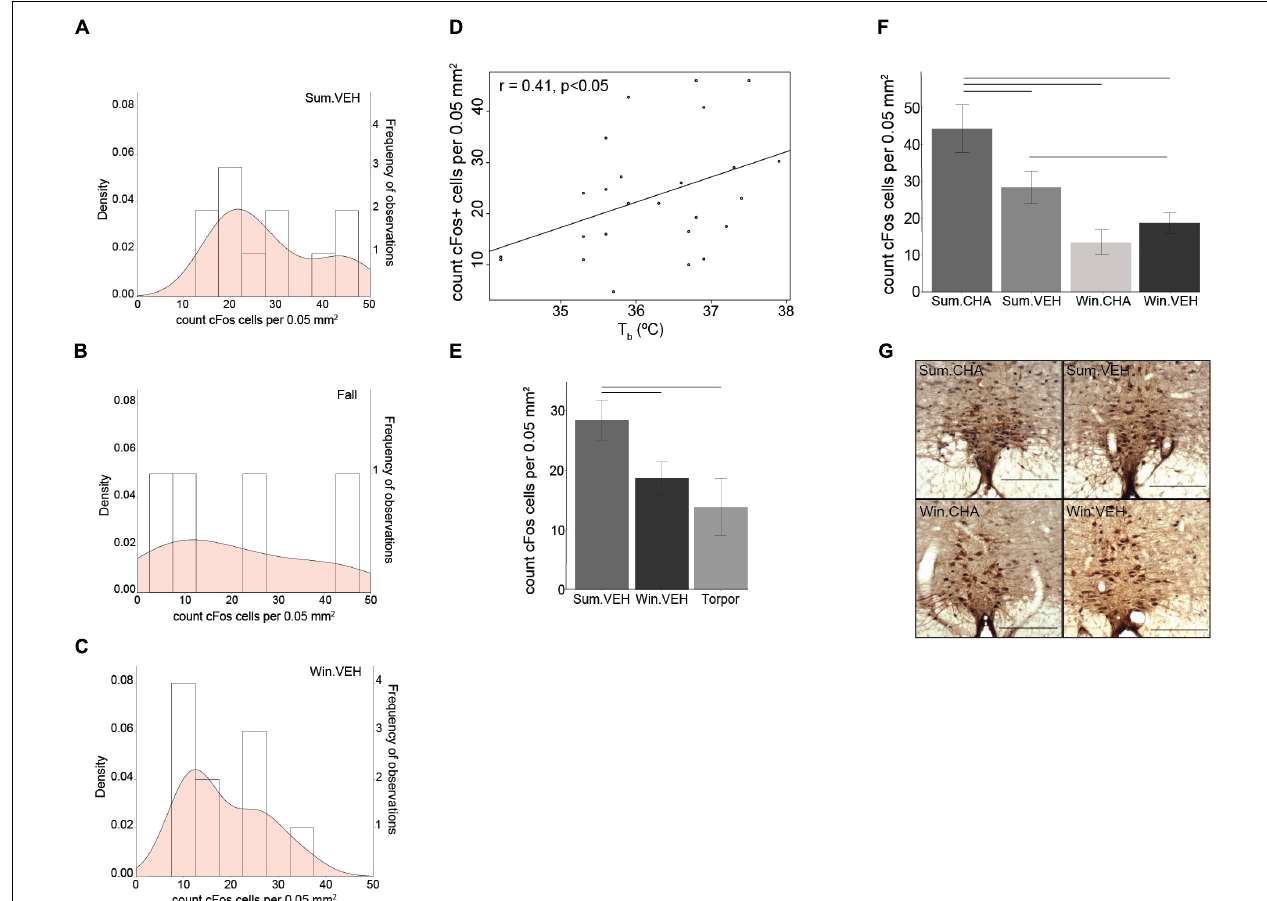
FIGURE 4 | Sympathetic tone decreases in winter. The density (probability distribution) of active neurons in the rPA is wider in Fall (B) compared to Summer (A) and Winter (C) . A seasonal decrease in euthermic T b correlates with a seasonal decrease in rPA neuronal activity (D) . rPA activation is higher in Summer euthermia compared to Torpor and Winter euthermia (E) and significantly increases after CHA in Summer, but not in Winter (F) . Photomicrographs of double stained brain sections in (G) , TPH neurons (brown) used to identify the rPA and cFos (black) are shown in the 4 treatment groups (Sum.CHA, Sum.VEH, Win.CHA, and Win.VEH), scale bar 200 µ m. Horizontal bars represent differences between groups, p < 0.05, t -test in (E,F) , n =